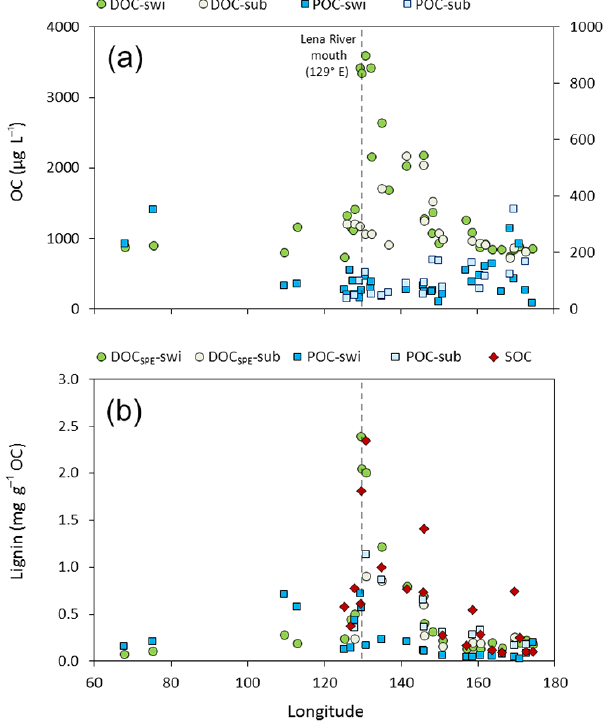
Figure 2. Longitudinal distribution of organic matter content in water and sediment samples. (a) Organic carbon concentrations (µgL − 1 ) in DOC (green circles) and POC (blue squares). The left y axis is for DOC and the right y axis for POC. (b) Lignin con- centrations (mgg − 1 OC) in DOC SPE (green circles), POC (blue squares) and SOC (red diamonds); swi: seawater intake samples (surface water samples at 8m depth); sub: samples obtained by submersible pump (near-bottom water samples, 5m above bottom). Dashed lines indicate the latitude of the Lena River